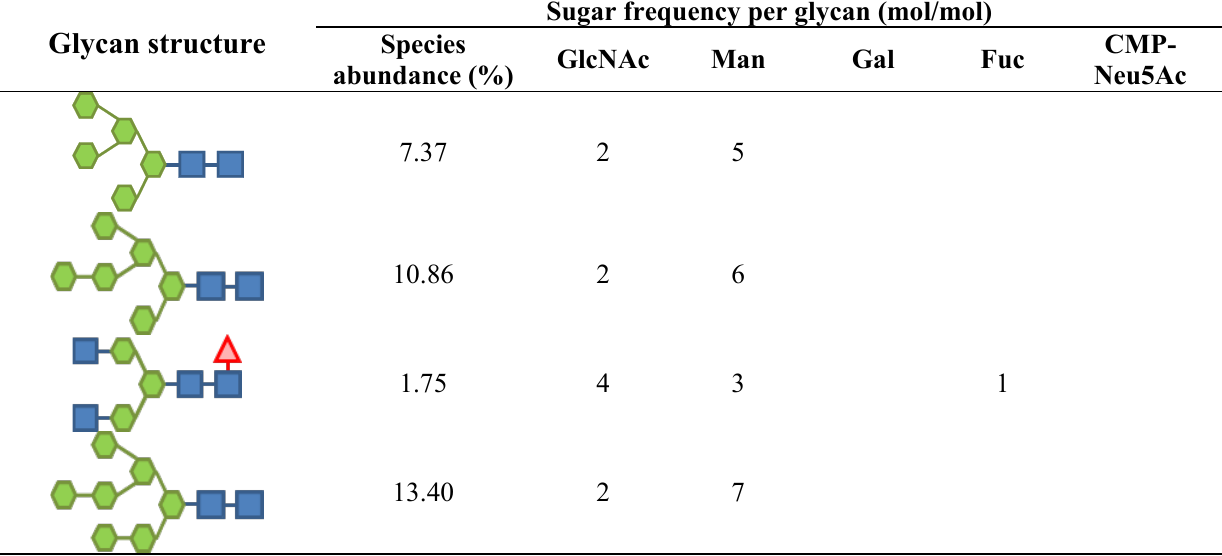
Table A1. Summary of the relative abundances of N-linked glycan structures used to obtain an average glycan